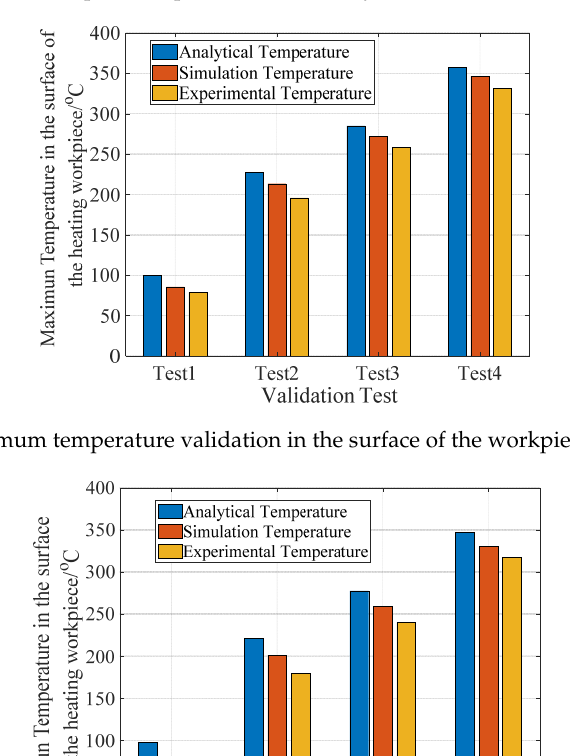
Figure 17. Maximum temperature validation in the surface of the workpiece ( I = 430 A, f = 37.6 kHz, Test 9: v = 3 mm/s; Test 2: v = 5 mm/s; Test 6: v = 8 mm/s; Test 10: v = 10 mm/s). Table 2. Maximum temperature and the relative errors with experimental results. Test